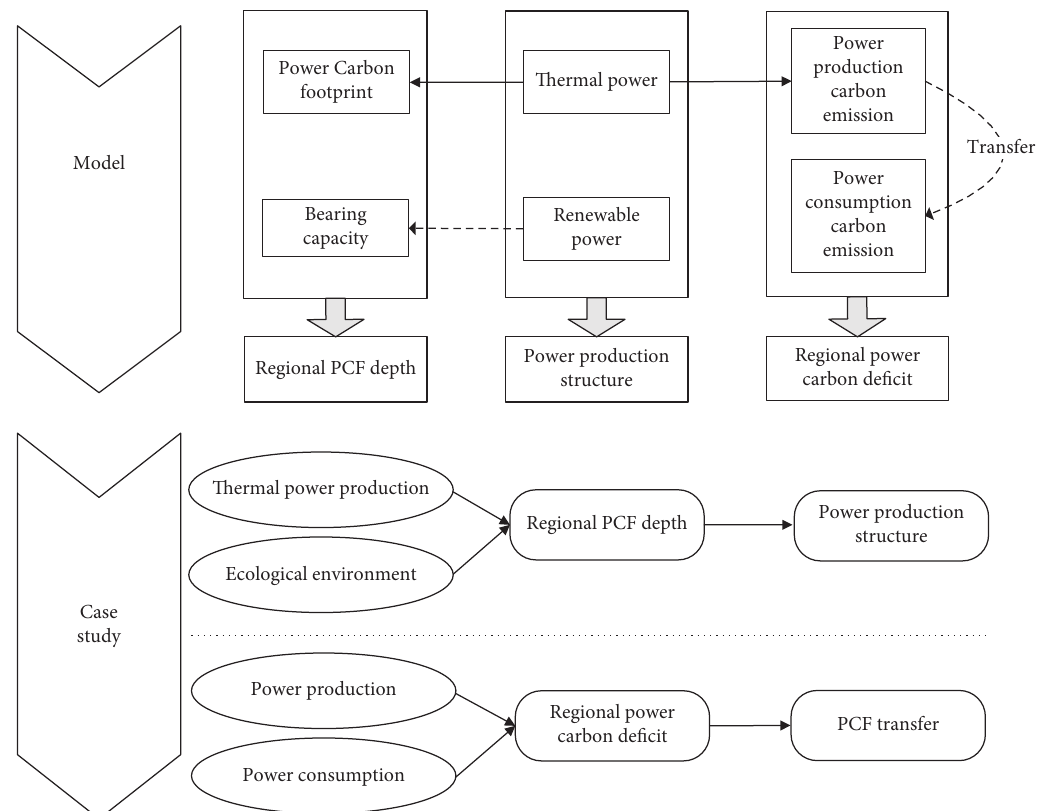
Figure 1: The research process of China’s power carbon